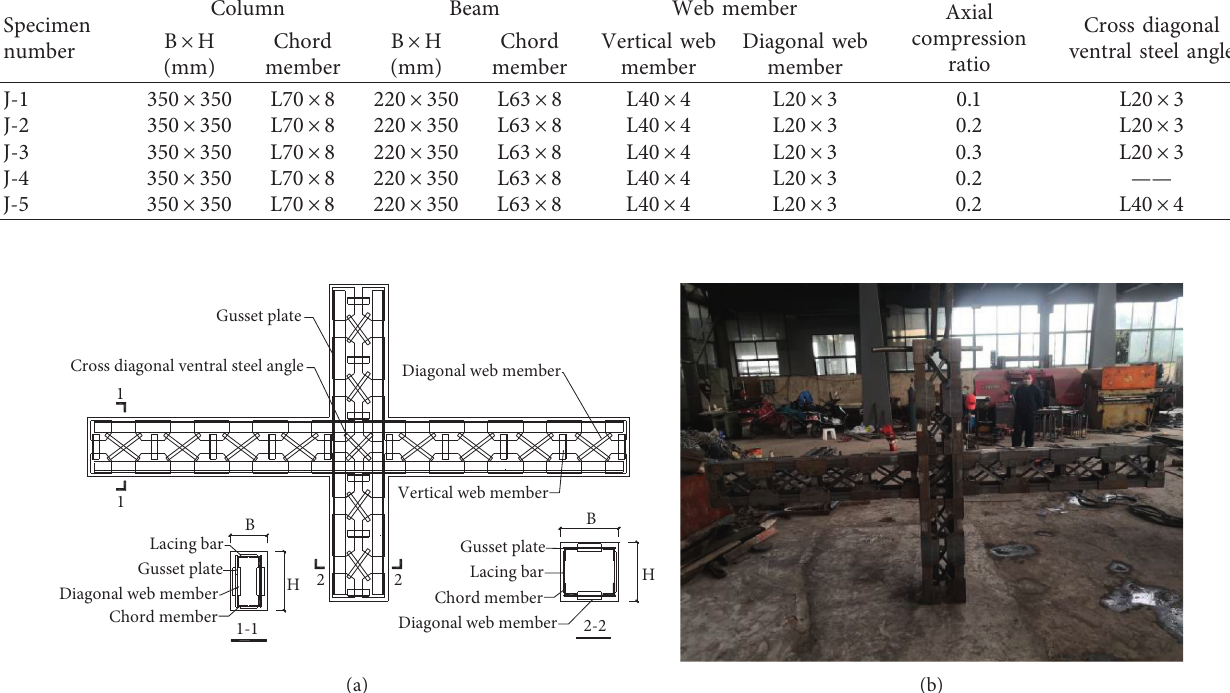
Table 1: Component design parameters.